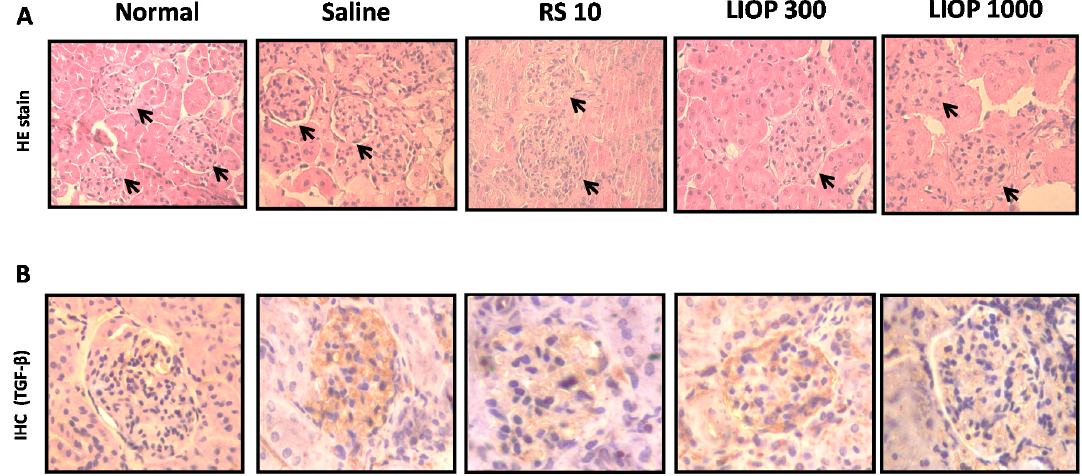
Figure 6. Morphological and immunohistochemical examination. Histopathological study of the renal cortex in C57BL/6 mice with HFD + STZ-induced diabetic nephropathy was examined after LIOP (300 and 1000 mg/kg) and rosiglitazone (10 mg/kg) treatment as compared to the effects of the saline group, alternatively at eight weeks. In the normal group, focal glomerulus ( black arrow ) remained relatively intact and numerous with hematoxylin and eosin staining ( A ). Original magnification: ×100. Representative renal cortex sections with immunostained TGF- β (in brown color ) were shown as in glomerulus area treated with LIOP (300 and 1000 mg/kg) and rosiglitazone (10 mg/kg) at eight weeks ( B ). Original magnification: ×400. Normal: native control; Saline: vehicle from Inonotus obliquus